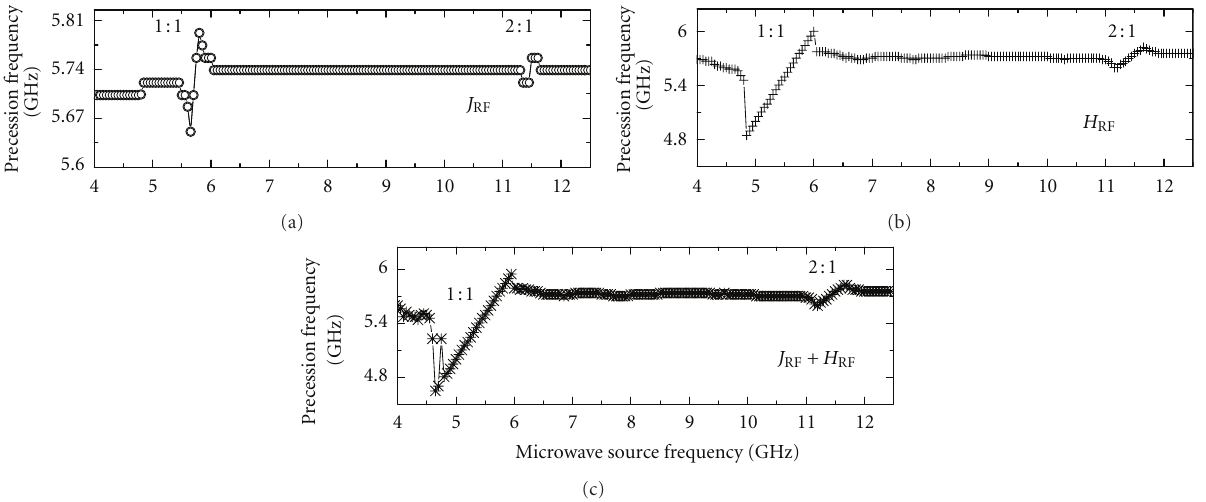
Figure 2: Response of the STO self-oscillation for H DC = 250mT and J DC = − 5 × 10 7 A/cm 2 as a function of the microwave source frequency when (a) J RF = 2 × 10 7 A/cm 2 , (b) H RF = 1mT, and (c) RF current J RF = 1 × 10 7 A/cm 2 and RF field H RF = 1mT are applied together at the same frequency. The locking regions for the frequency ratio of 1 :1 and 2:1 are also